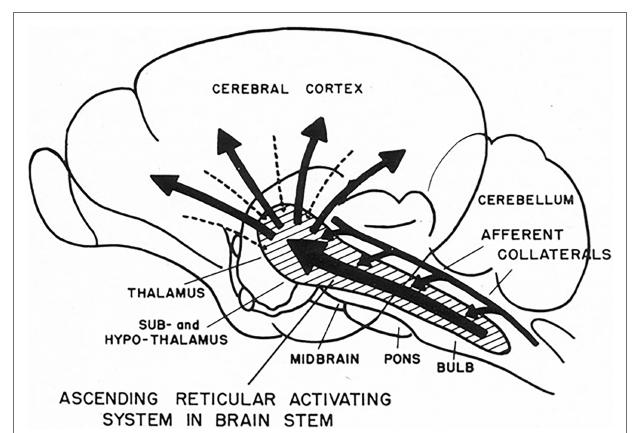
FIGURE 5 | 1951 conceptual drawing of the ascending reticular activating system (ARAS) . Note there is no indication of descending signals to the heart. (From Starzl et al., 1951) (Used with permission of the American Physiological